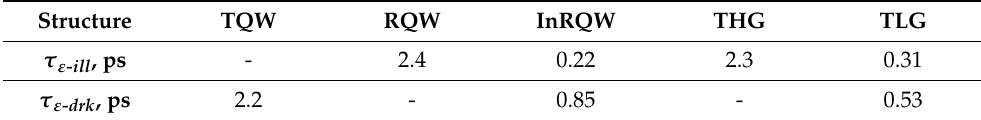
Table 3. Electron energy relaxation time τ ε -ill and τ ε -drk under illumination and in the dark, respec- tively, evaluated from I-V characteristics of various asymmetrically necked semiconductor structures [model of Equation